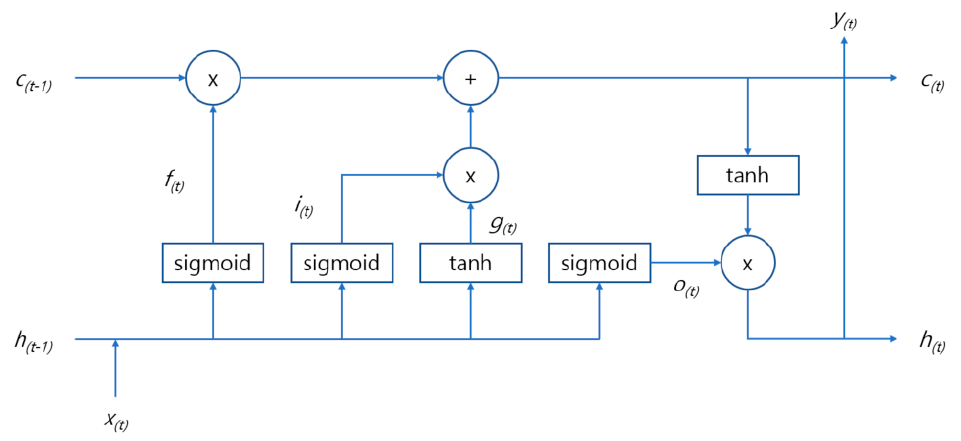
Figure 5. Long Short-Term Memory Cell.